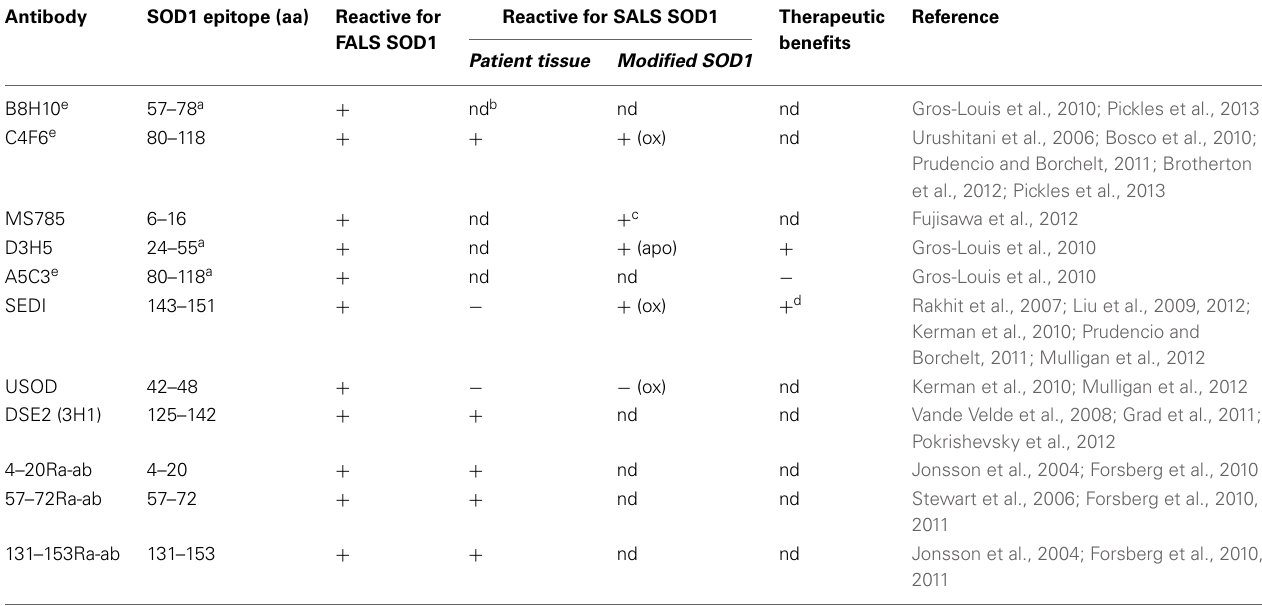
Table 1 | Conformation specific antibodies recognize regions of SOD1 exposed upon misfolding. Antibody SOD1 epitope (aa) Reactive for FALS